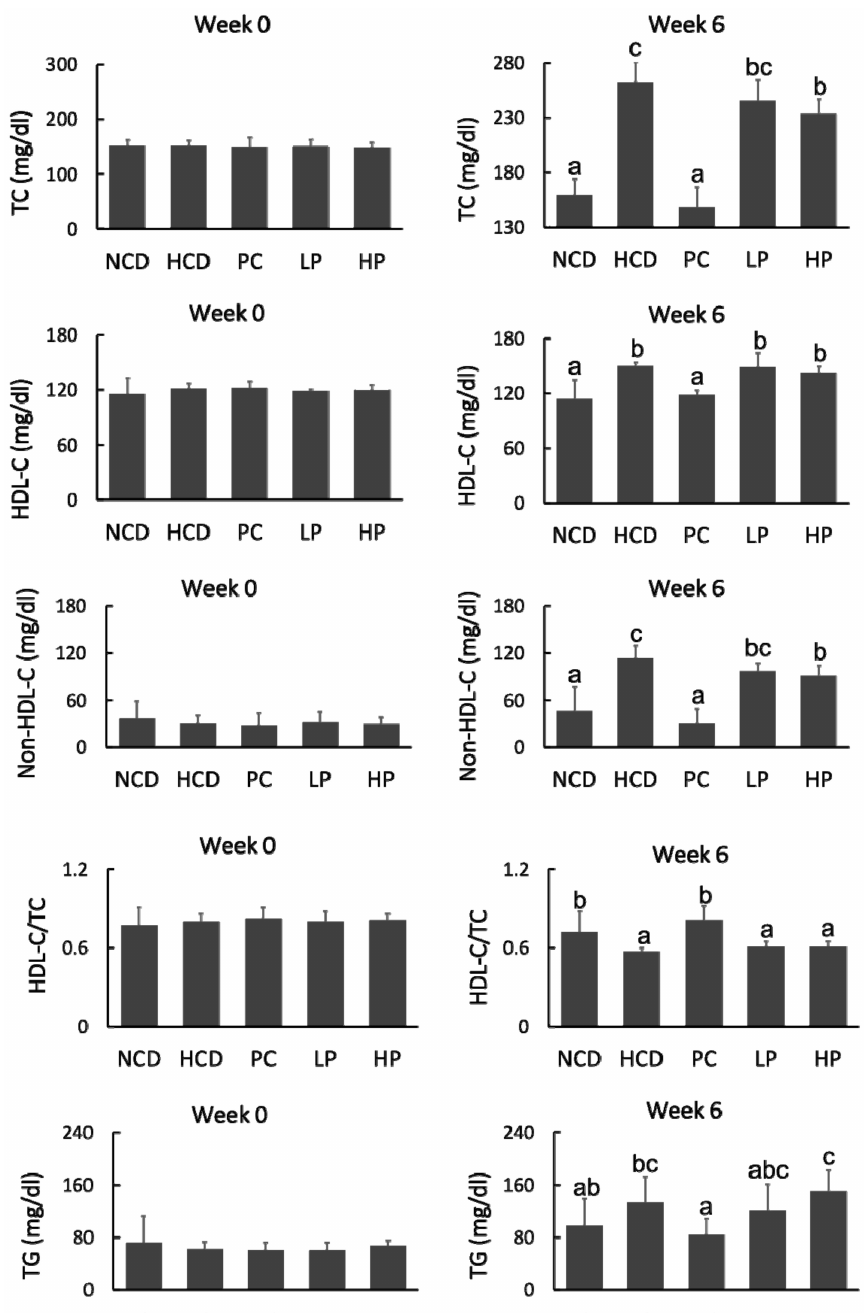
Figure 3. Changes in total cholesterol (TC), high-density lipoprotein cholesterol (HDL-C), non-HDL cholesterol (Non-HDL-C), HDL-C / TC and triglyceride (TG) of hamsters fed one of five diets: NCD, no cholesterol diet; HCD, high cholesterol diet containing 0.1% cholesterol; PC, high cholesterol diet containing 0.5% cholestyramine; LP, high cholesterol diet containing a low dose (0.1%) soybean germ phytosterols (SGP); HP, high cholesterol diet containing a high dose (0.2%) of soybean germ phytosterols (SGP). n = 8 for each group. a,b,c = means with di ff erent superscript letters di ff er significantly at p <